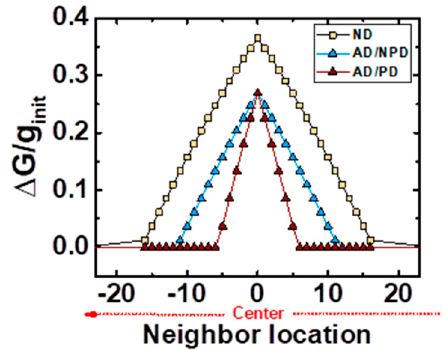
Figure 10. Neighborhood interaction functions based on the STDP rule. The ND curve (yellow squares) shows an example where any delay is considered. AD / NPD curve (blue triangles) consists in a delayed response from the main spiking neuron, but minimum propagation delay. The AD / PD curve is an example of the presence of both delays.